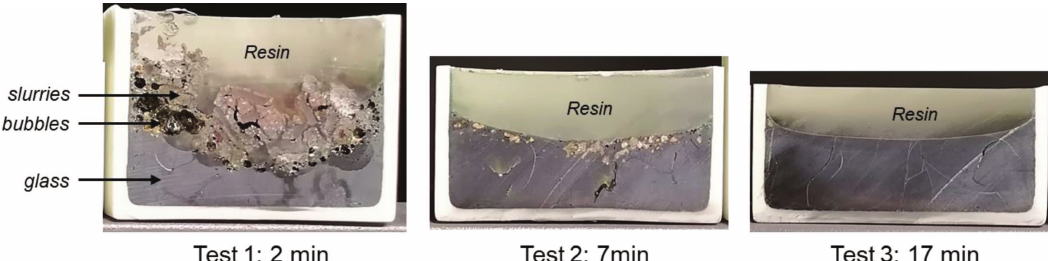
Fig. 6. Half-cut crucibles after the tests to see the evolution of the material with the time of digestion.